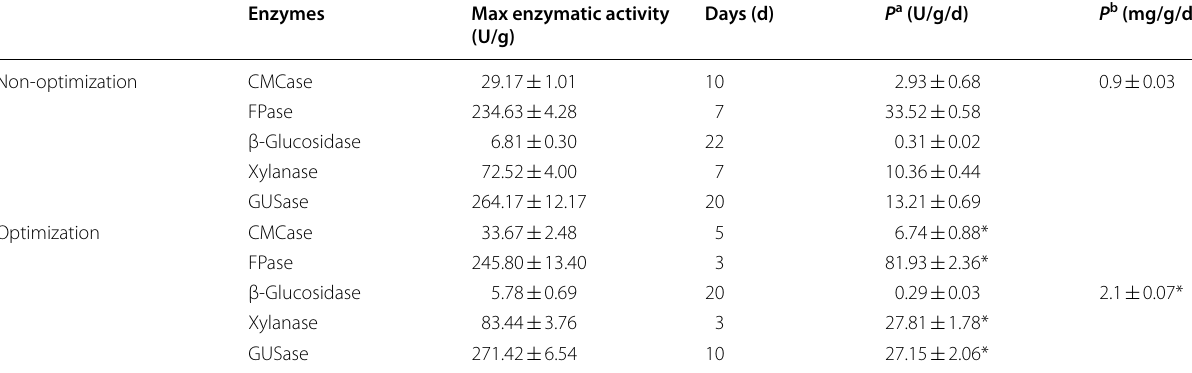
a The production of lignocellulolytic enzymes when reaching maxim enzymatic activity b The production of GAMG when the percent conversion of glycyrrhizin reaches 90%. * P values analyzed by t test are statistically significant for a confidence level of 95% ( P < 0.05)